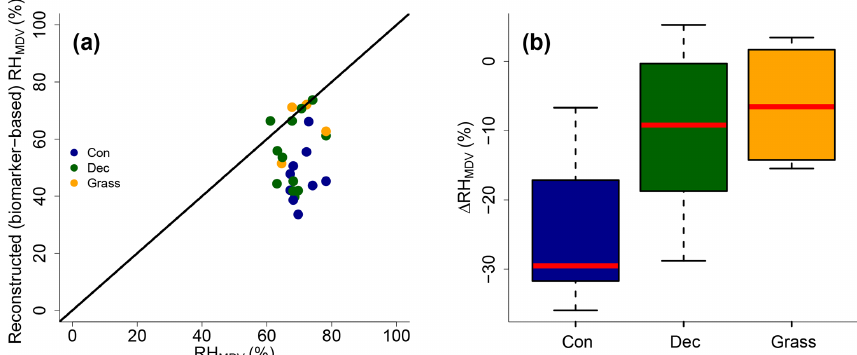
Figure 10. (a) Comparison of reconstructed (biomarker-based) RH MDV values and climate station RH MDV data. The black line indicates the 1:1 relationship. (b) Differences between reconstructed and climate station RH MDV values ( (cid:49) RH MDV = reconstructed − climate station RH MDV ) for the three different vegetation types along the transect. Abbreviations: con: coniferous forest sites ( n = 9); dec: deciduous forest sites ( n = 11); grass: grassland sites ( n =